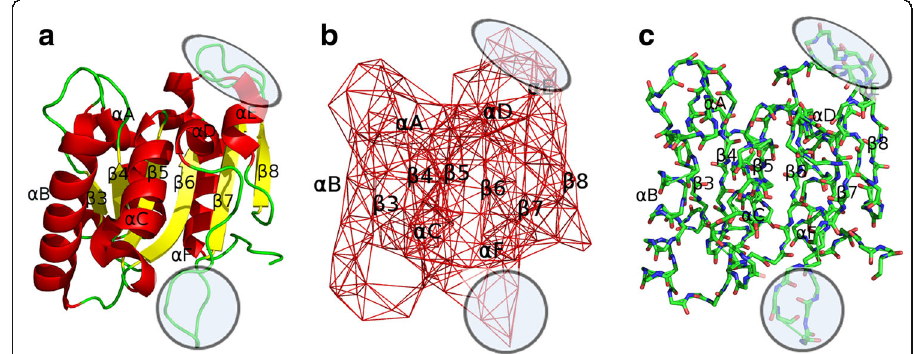
Table 1 The PDB structure IDs of Lipase A and its six mutants used for analysis, with the mutated sites and their optimum functional temperature PDB ID